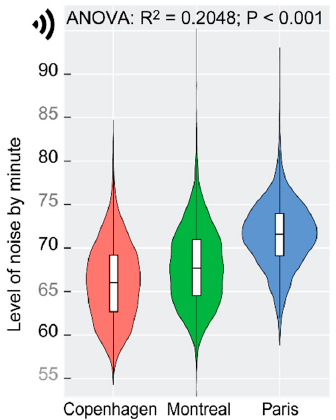
(cid:48) exposure to road tra ffi c noise by city. ANOVA, analysis of Figure 4. Cyclists ′ exposure to road traffic noise by city. ANOVA, analysis of variance. Figure 4. Cyclists